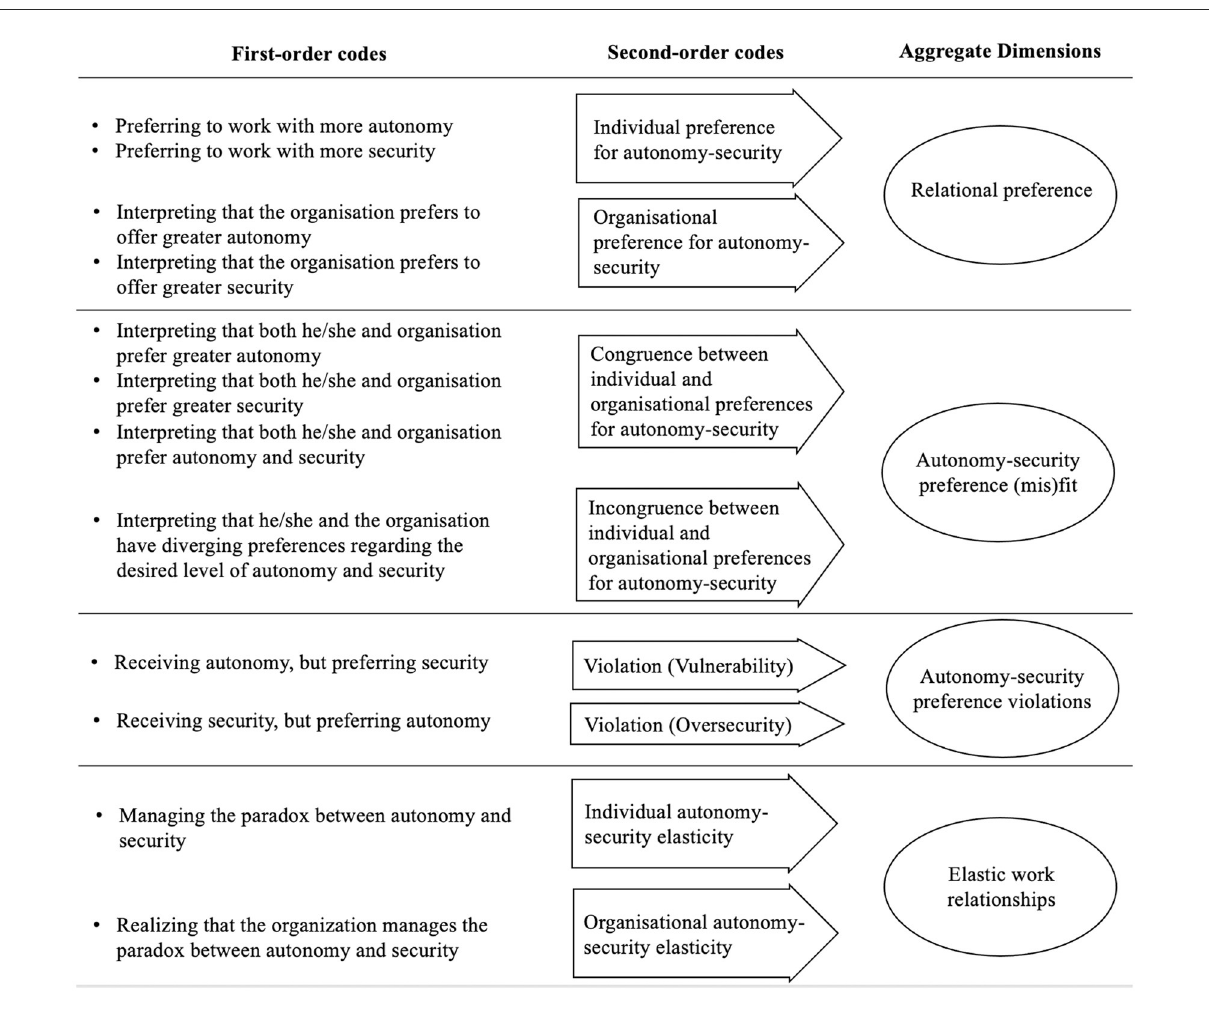
FIGURE1 General structure of derivation of codes and